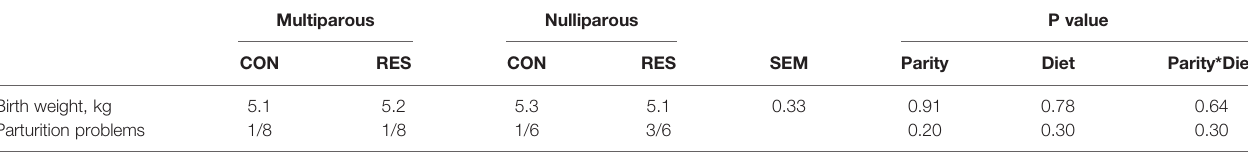
TABLE 3 | Birth weight means (kg) and number of birth-related problems (number of ewes and/or lambs per treatment).